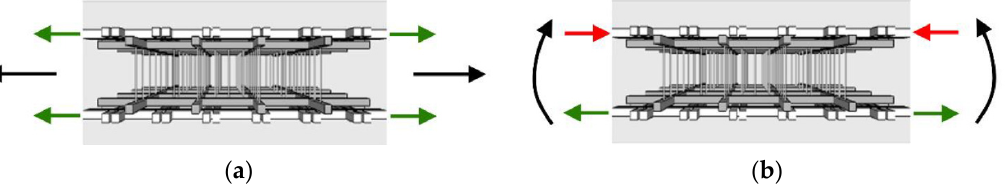
Figure 9. Evaluation of textile displacement under ( a ) tensile (green tensile stresses in top and bottom region) and ( b ) flexural loading conditions (green tensile stresses in bottom region and red compressive stresses in top region).